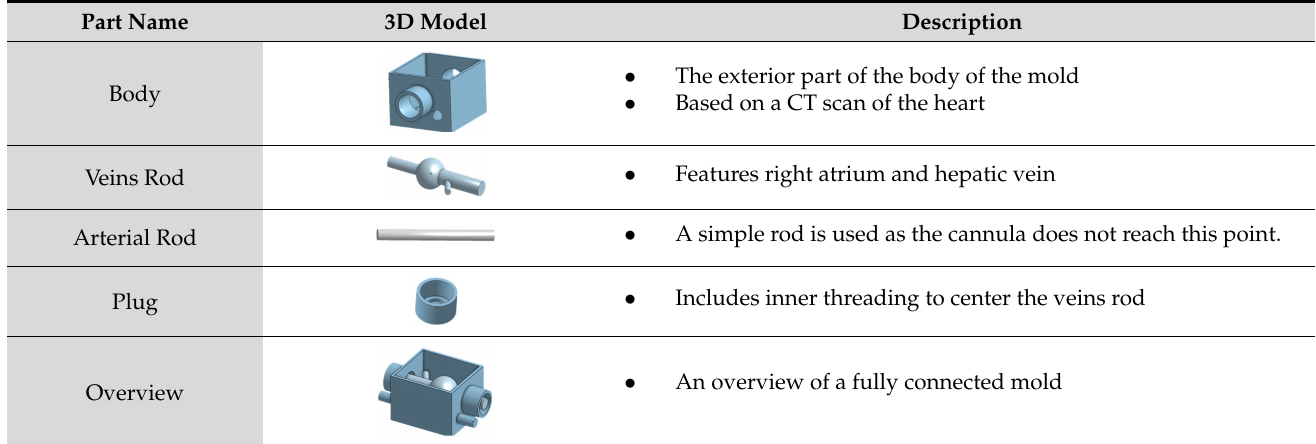
Table 3. Design of the heart pad